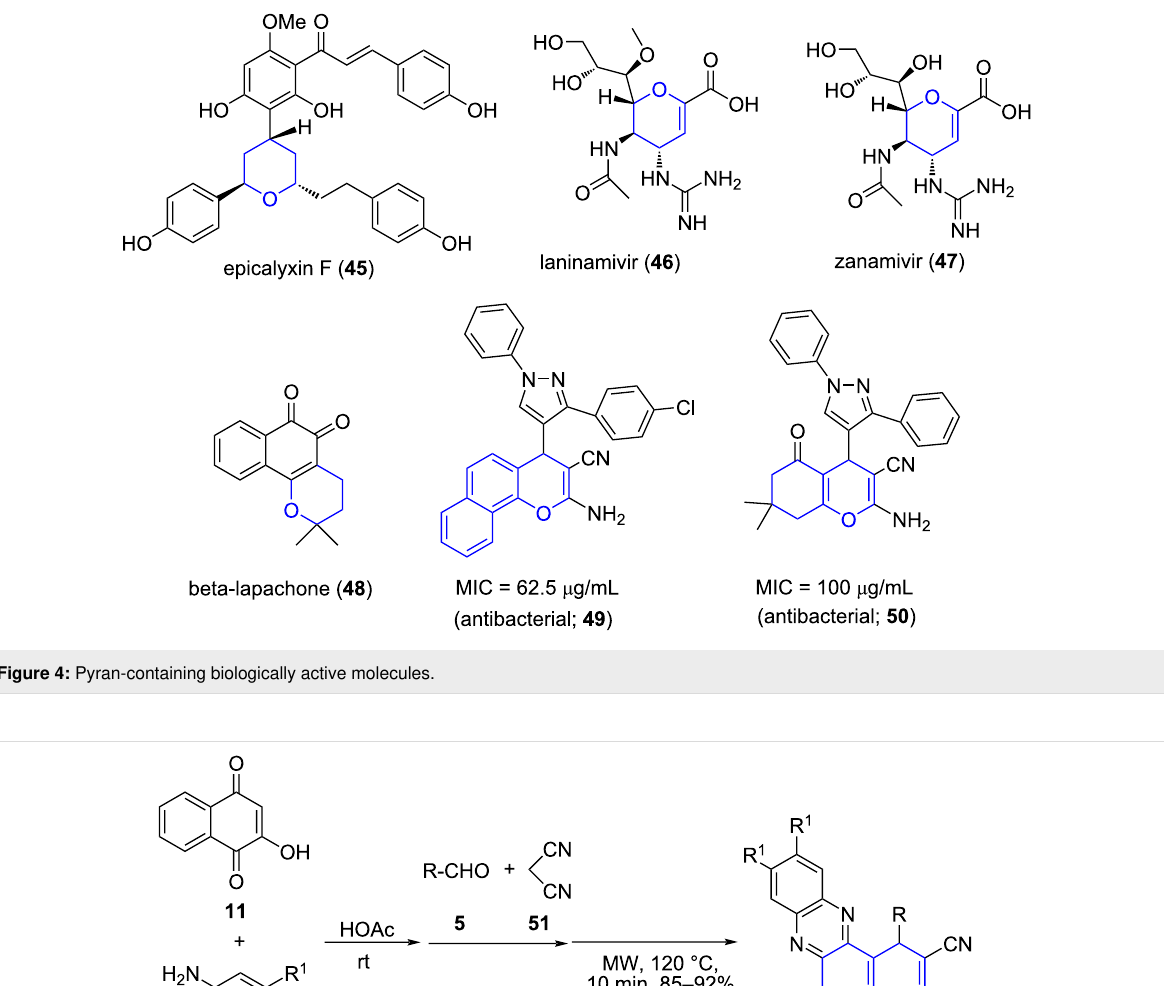
Scheme 17: Synthesis of functionalized